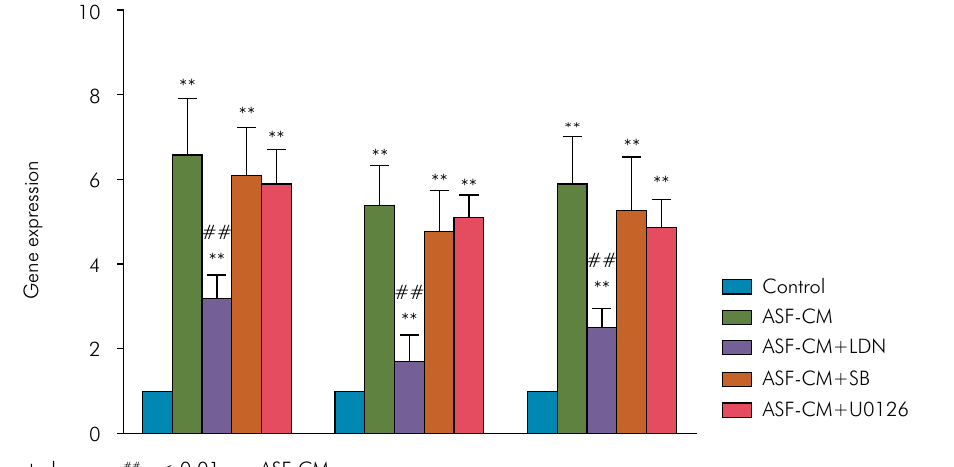
Figure 5. RT-PCR analysis of the expression of Ambn , ENAM , and Ck14 of iPS cells induced by the control medium, ASF-CM, or ASF-CM respectively supplemented with 200 nM LDN-193189 (LDN, a selective SMAD1/5 inhibitor), 10 μ M SB203580 (SB, a selective P38 inhibitor), or 10 μ M U0126 (a selective ERK1/2